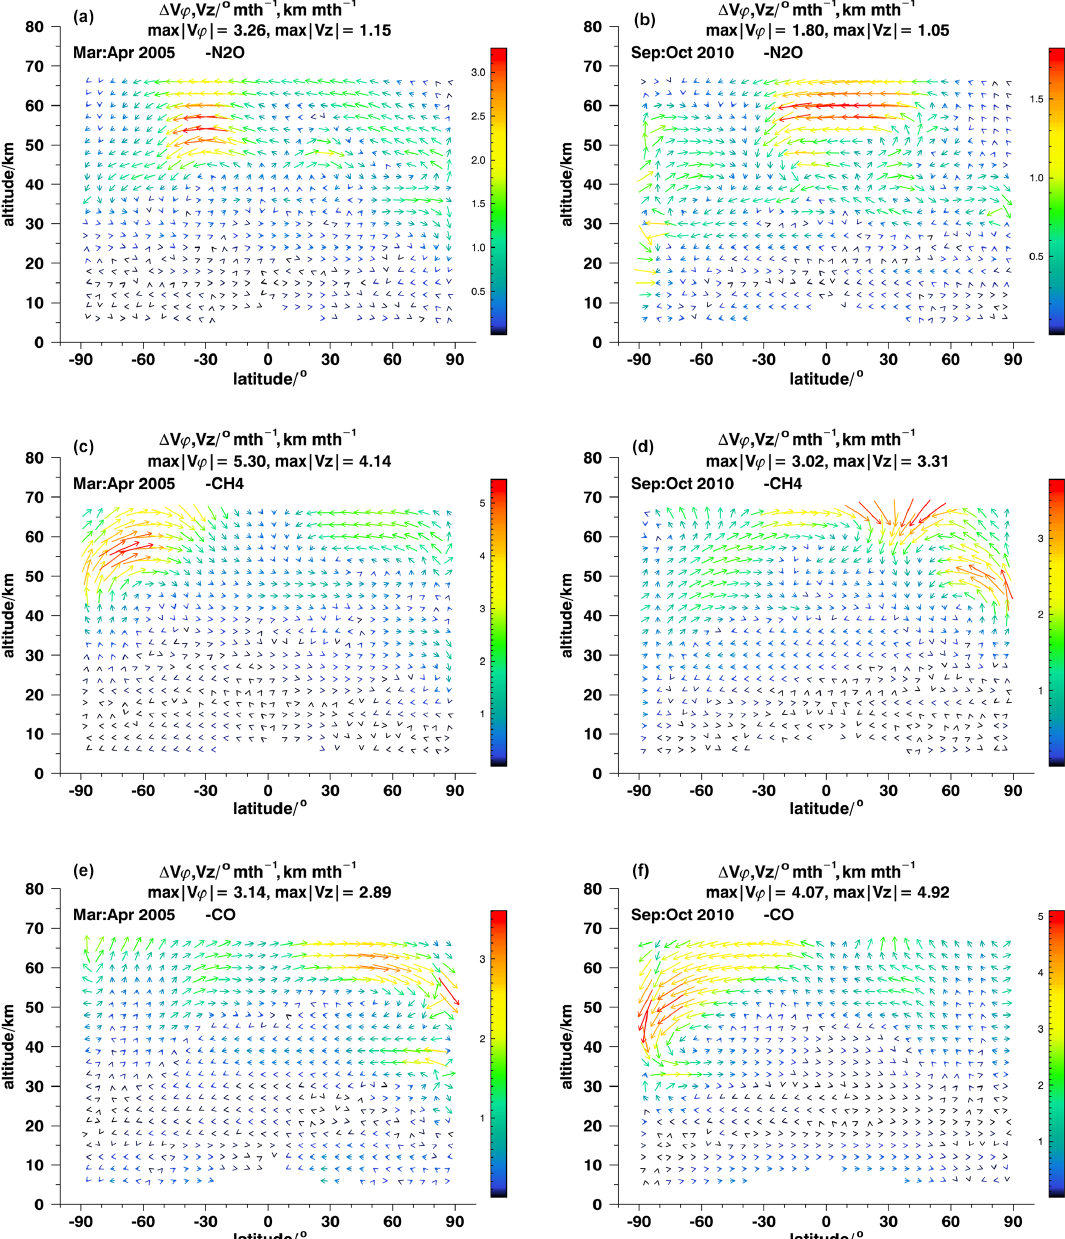
Figure 10. Differences between ANCISTRUS runs with one species omitted and all nine species included for March–April 2005 (a, c, e) and September–October 2010 (b, d, f) . The missing species are N 2 O, CH 4 , and